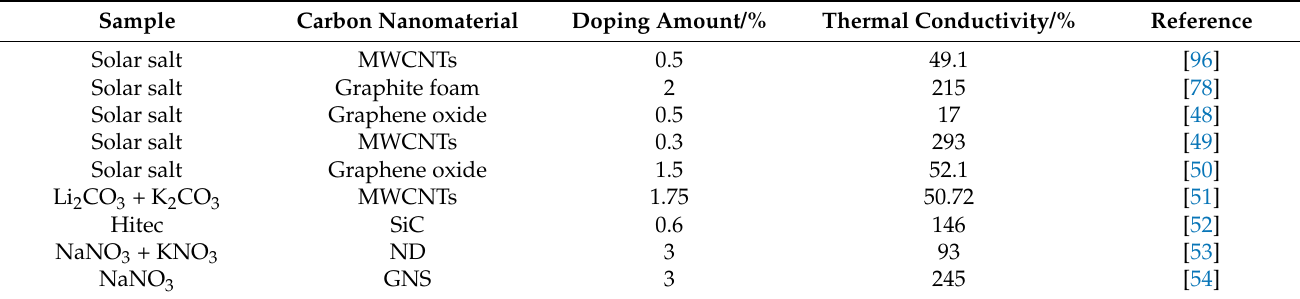
Table 3. Improvement of heat transfer performance of nano carbon